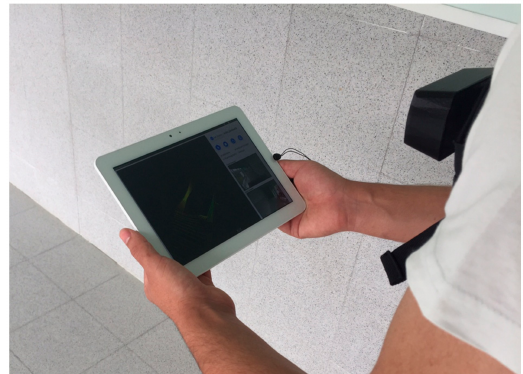
Figure 2. Image of the operator during inspection, with the wearable prototype controlled through the